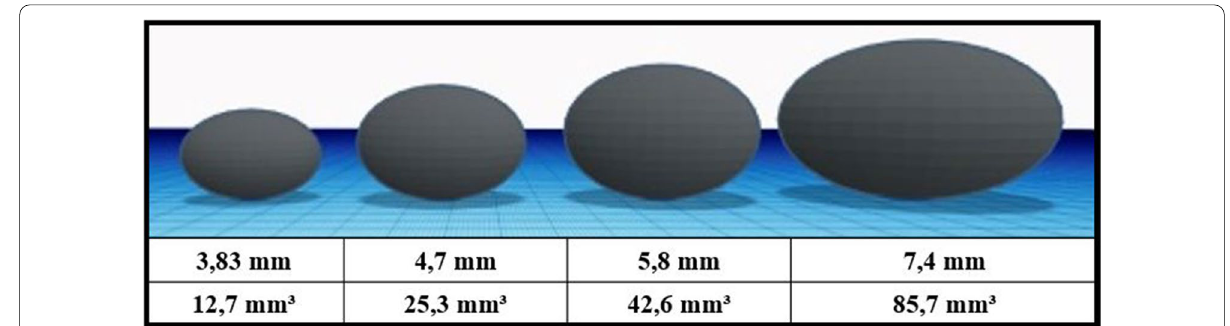
Fig. 3 Illustration of volumetric increase relative to serial mammograms. First line: The largest diameter of the density on mammography (mm) Second line: The volumetric measurement of the density (mm 3